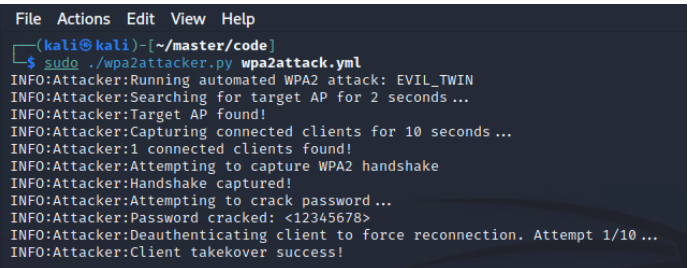
Figure 12. Performing the Evil Twin